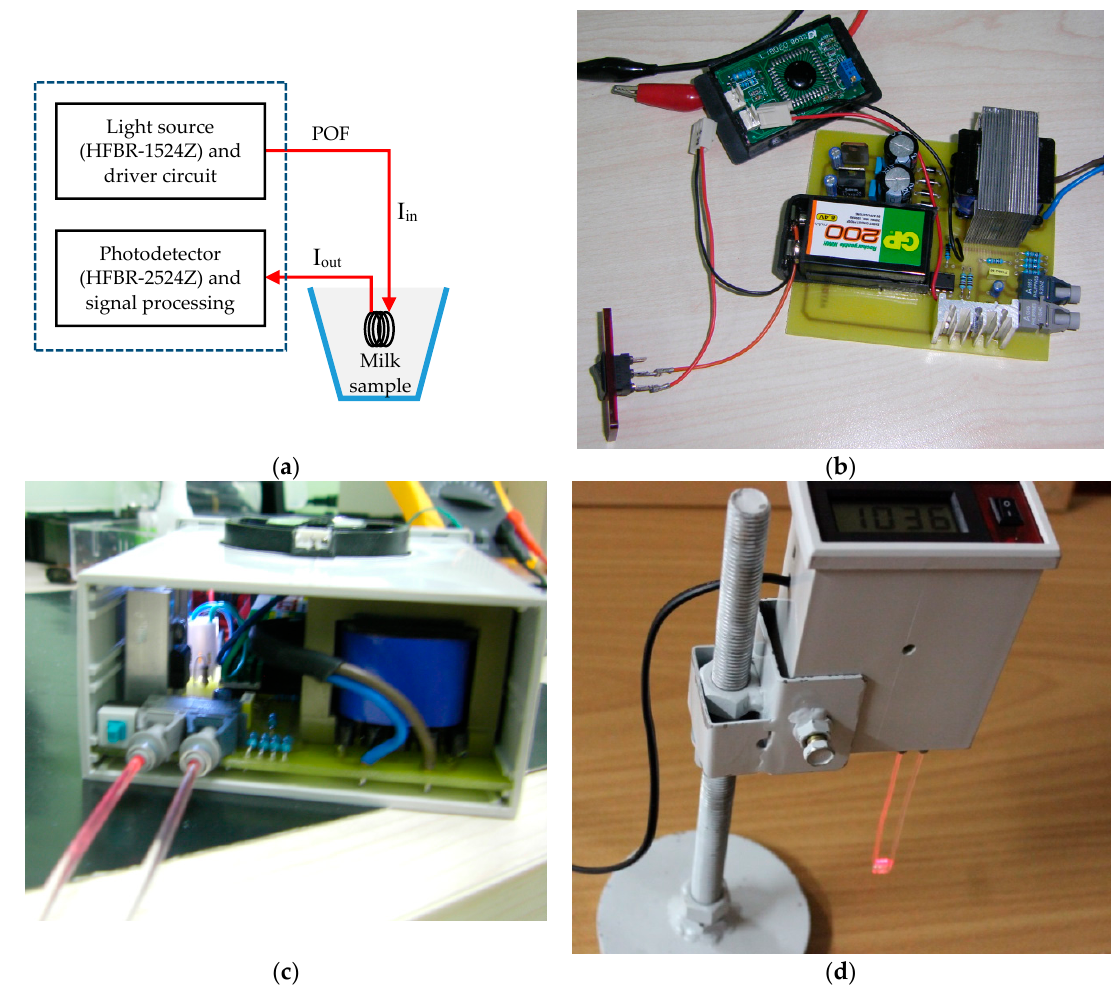
Figure 2. Sensor setup. ( a ) Schematic view of the setup; ( b ) printed circuit board placement; ( c ) inside view; ( d ) the final design ready for immersion into the milk sample.